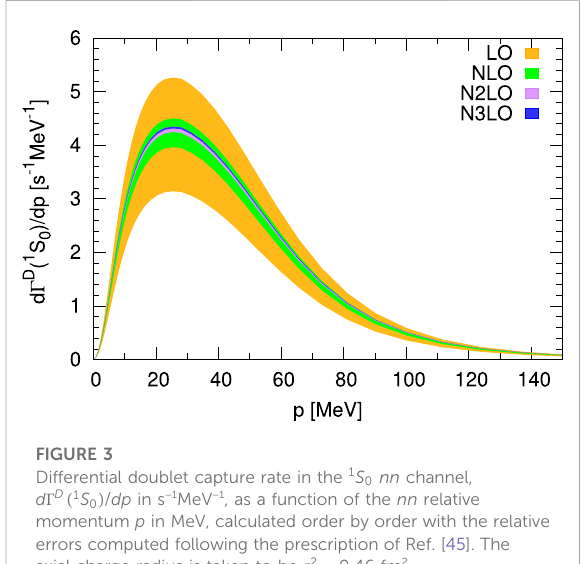
FIGURE 3 Differential doublet capture rate in the 1 S 0 nn channel, ) / dp in s − 1 MeV − 1 , as a function of the nn relative d Γ D ( 1 S 0 momentum p in MeV, calculated order by order with the relative errors computed following the prescription of Ref. [45]. The axial charge radius is taken to be r 2 A (cid:2) 0 . 46 fm 2 .